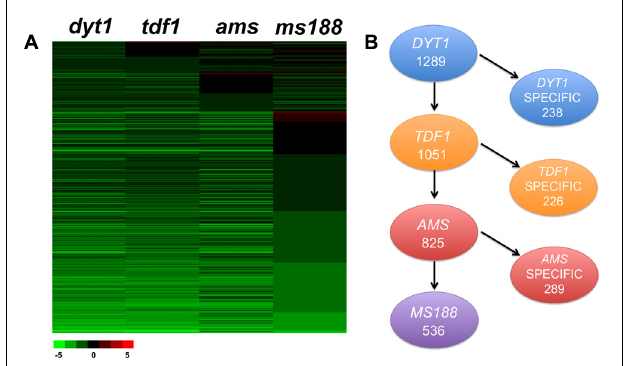
FIGURE 2 | Comparative analysis of tapetum expressed genes differentially down-regulated in dyt1, tdf1, ams, and ms188 mutants. (A) Transcription changes of tapetum expressed genes differentially down-regulated in dyt1, tdf1, ams , and ms188 mutants. Green and red colors represent lower and higher log2 fold change expression in mutants compared with the wild type. (B) Subsets of total differentially and commonly expressed genes down-regulated in the four